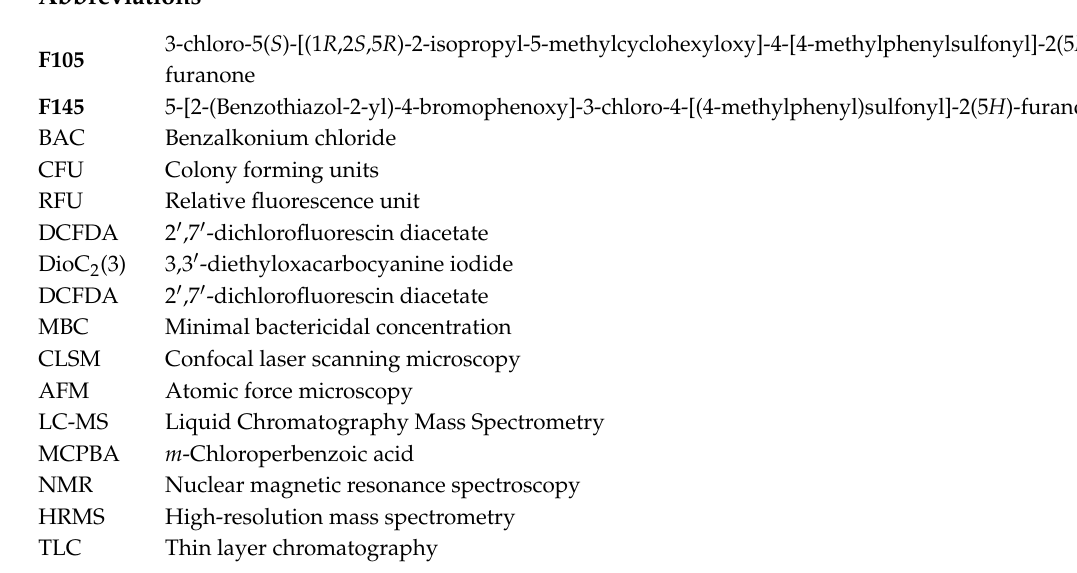
Table S4: S. aureus proteins with altered mobility after incubation with F105 in